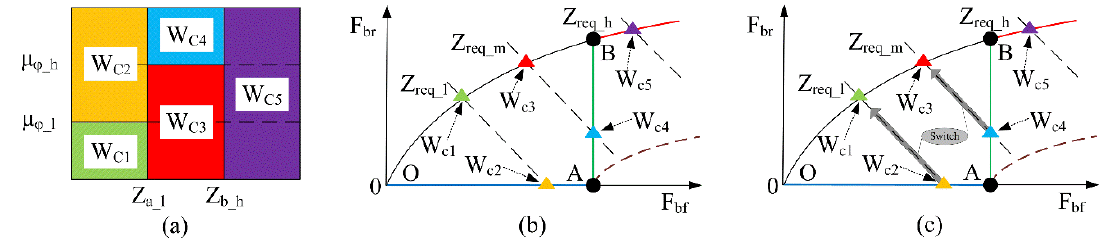
Figure 5. Allocation logic of five braking work-points in RRBCS: ( a ) area schematic; ( b ) logic schematic; and ( c ) switching logic schematic.